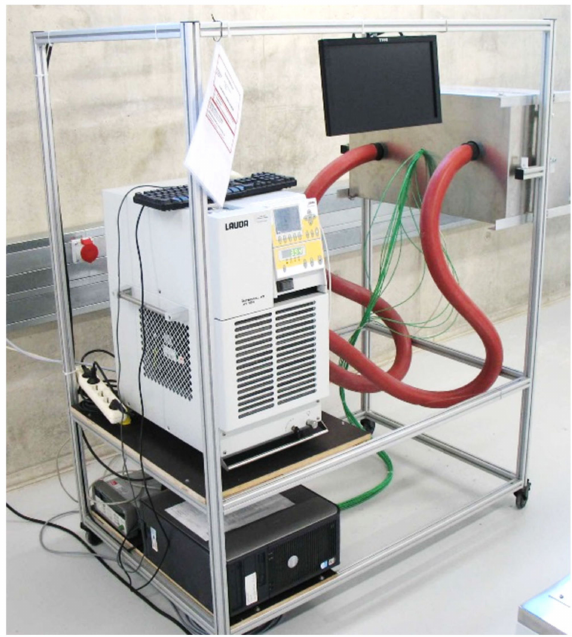
Figure 19. Pictures of stability testing device